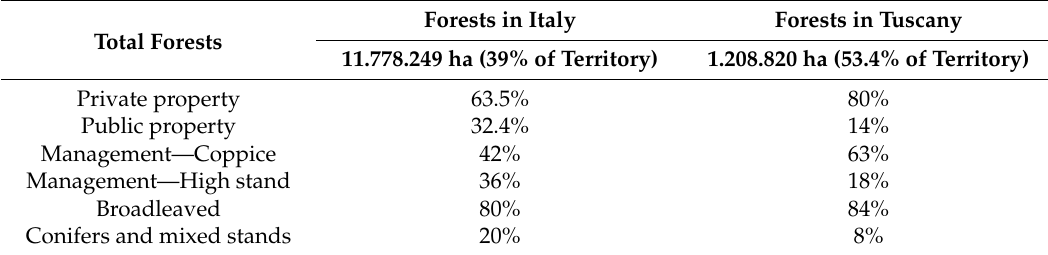
Table 2. The features of Italian forests show the prevalence of coppice woods as a management form. This is due to the better integration of these woods with the needs of agriculture and the high request of fuelwood and charcoal. Today coppice woods are reducing due to decreasing economic interests and to nature conservation strategies limiting this kind of management form. The data of Tuscany includes shrublands and the cultivation of trees for wood production on agricultural areas